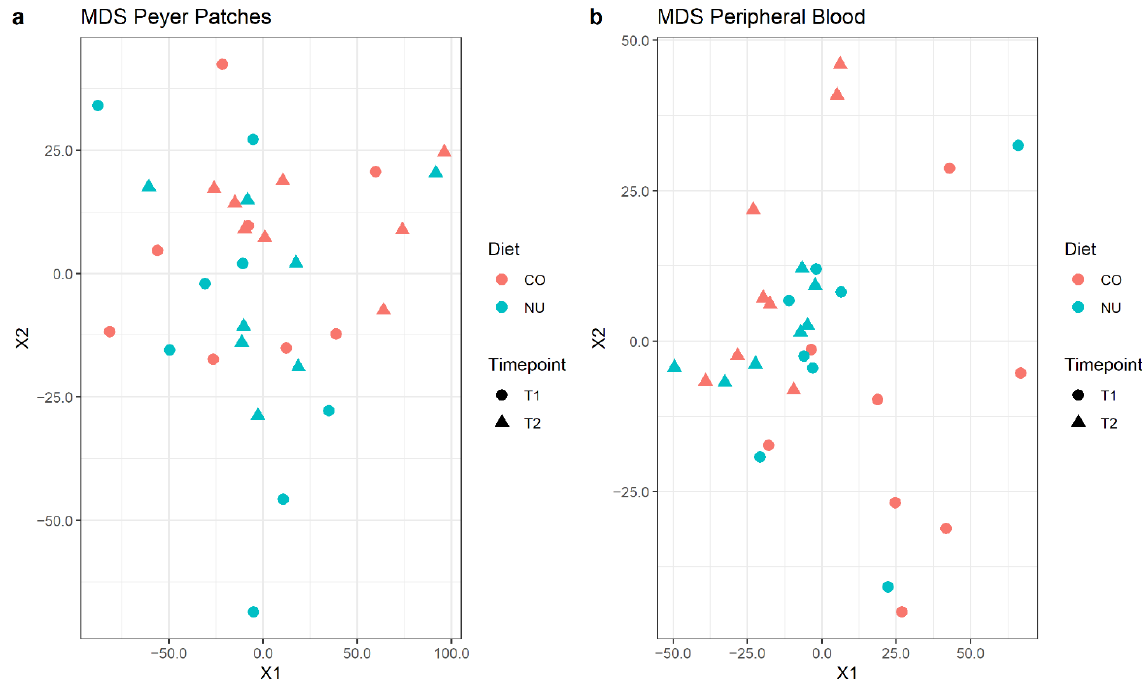
Figure 3. Multi-dimensional scaling (MDS) plots for normalized gene expression levels of JPP ( a ) and PB ( b ) at weaning (T1) and 12 d-post-weaning (T2), in control (CO) and nucleotide (NU) groups.